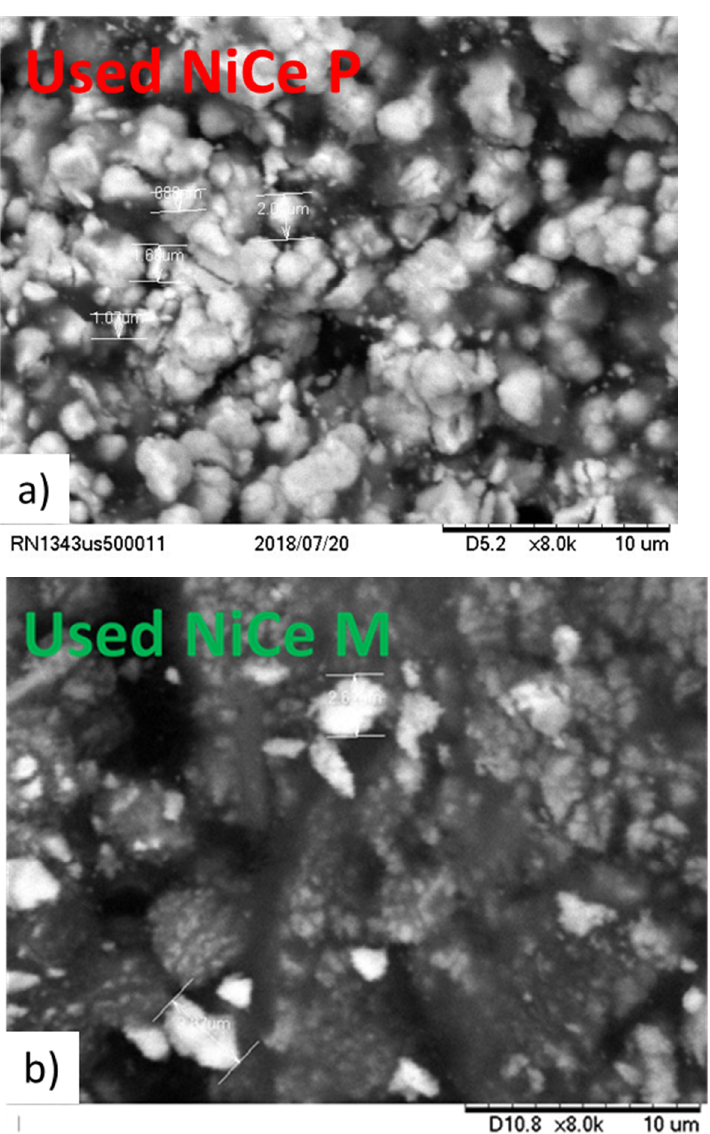
Figure 7. SEM images of used catalyst samples recovered after ethanol steam reforming tests: ( a ) Used NiCe P and ( b ) Used NiCe M.